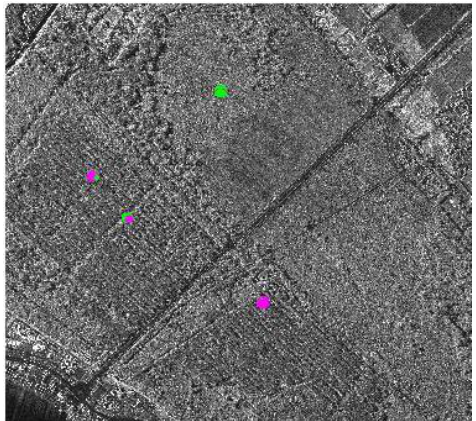
Figure 7. Castel Fusano thematic maps: vegetation map (left), soil map (right).